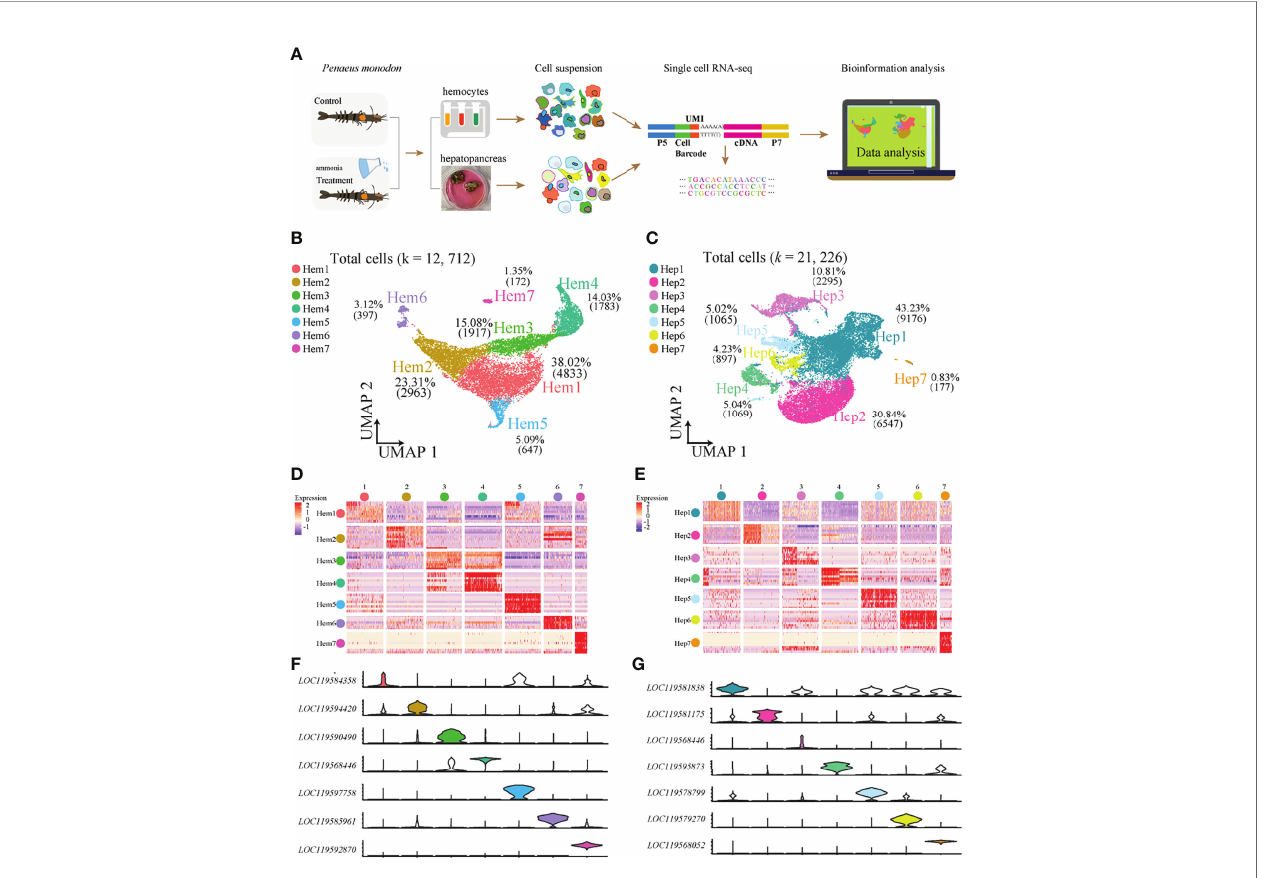
FIGURE 1 | ScRNA-seq of P. monodon haemocytes and hepatopancreas reveals their cellular subpopulations. (A) Overall work fl ow for cell sorting and single-cell data analyses. (B) UMAP plot of cell clusters from shrimp haemocytes. (C) UMAP plot of cell clusters from shrimp hepatopancreas. (D) Heatmap of the top 10 marker genes in haemocytes. (E) Heatmap of the top 10 marker genes in hepatopancreas. (F) Violin plots of the signi fi cantly marker genes in haemocytes. (G) Violin plots of the signi fi cantly marker genes in